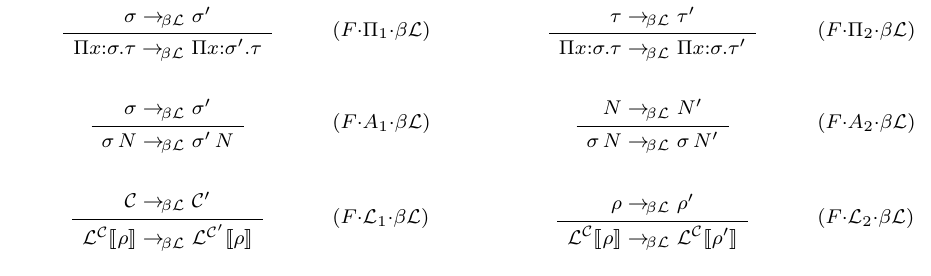
Fig. 3. β L -closure-under-context for kinds